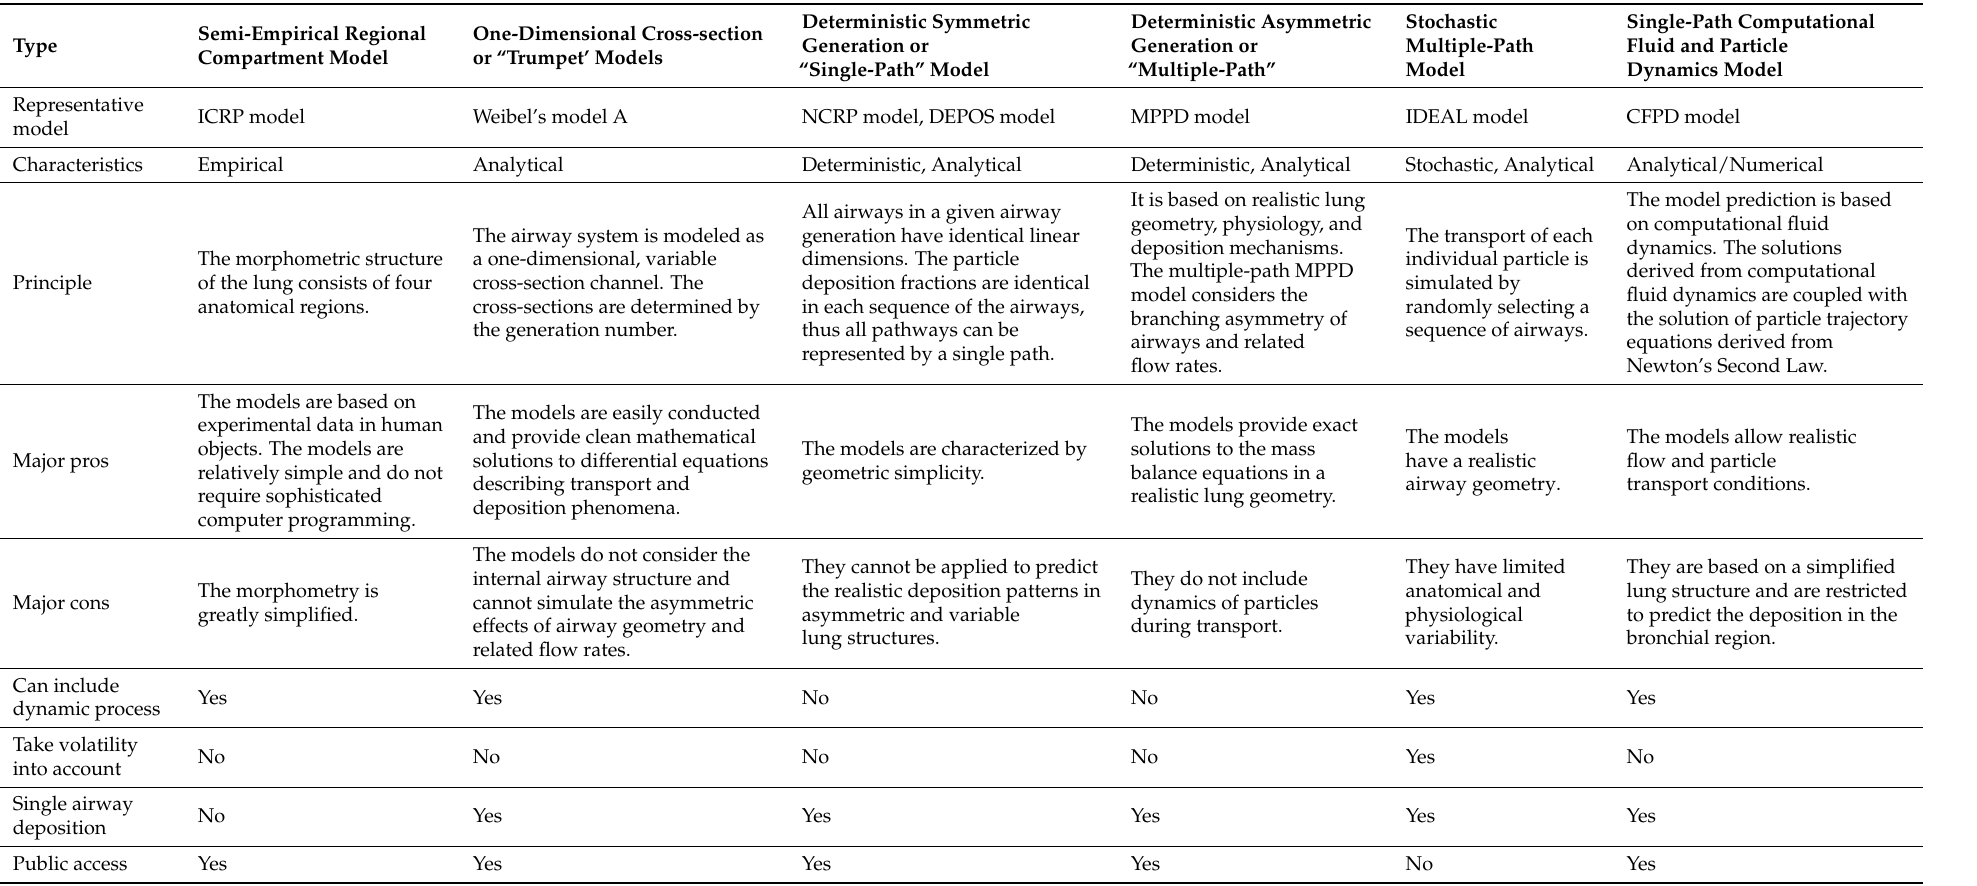
Table 2. The comparison of models to predict particle deposition in the human respiratory